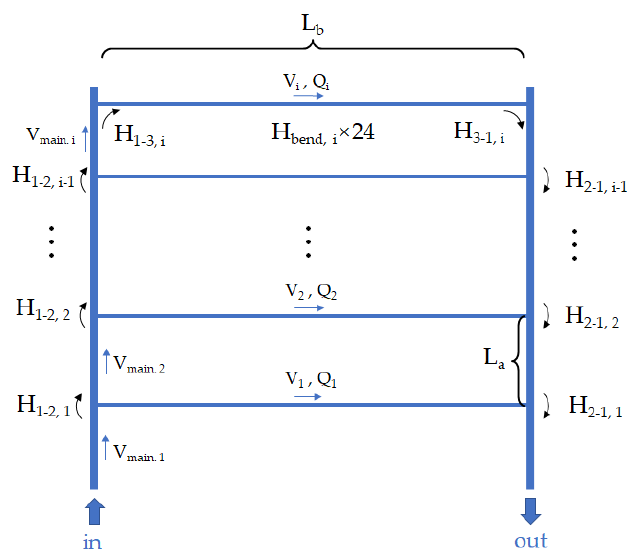
Figure 6. Schematic of the head loss for the i th branch.